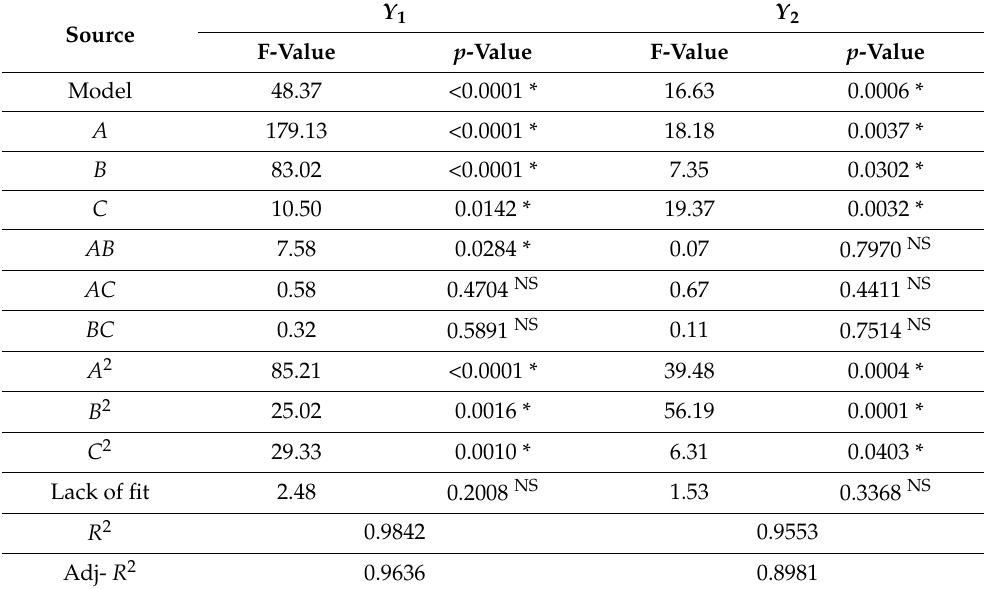
Table 3. Regression coefficient of the predicted second-order polynomial models for extraction yield and TSC.